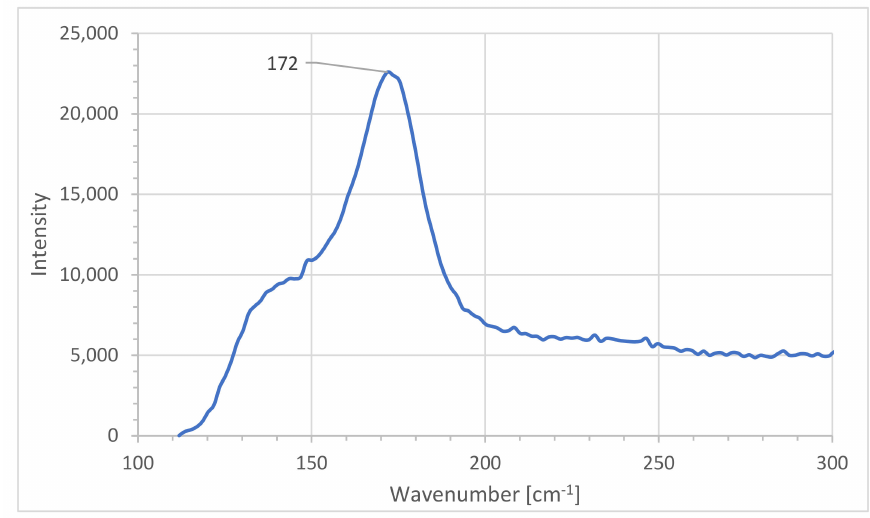
Figure 2. Raman spectroscopic analysis of [Cu(12-crown-4) 5 (H 2 O) 6 ]I 6 · 2I 2 . The range until 200 cm − 1 is used to identify the topology of polyiodides. The bands below this important range cannot be clearly assigned due to high luminescence except for two peaks at 172 and 142 cm − 1 . The absorption at 172 cm − 1 originates from the I 2 - units within [Cu(H 2 O) 6 (12-crown-4) 5 ]I 6 · 2I 2 in agreement with other studies